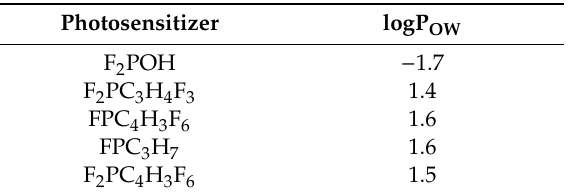
Table 1. Values of n-octanol / water partition coe ffi cients determined for sulfonated and sulfonate ester halogenated porphyrin